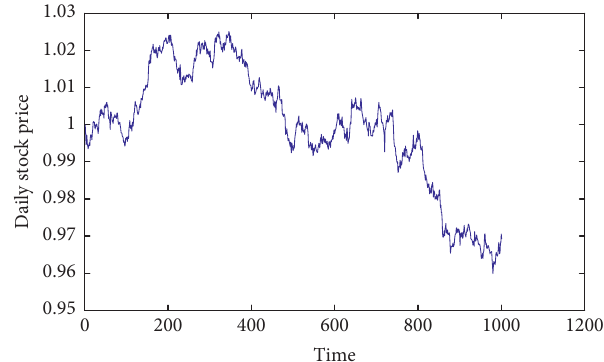
Figure 12: The simulated stock